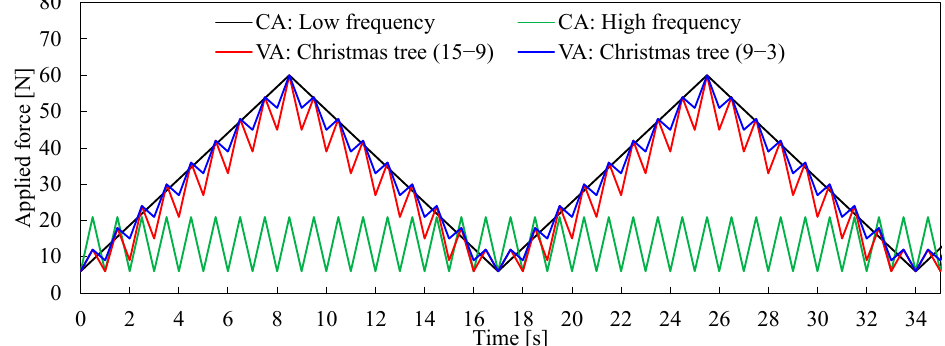
Figure 2. Four different load patterns used in the numerical simulation (CA: constant amplitude; VA: variable amplitude).